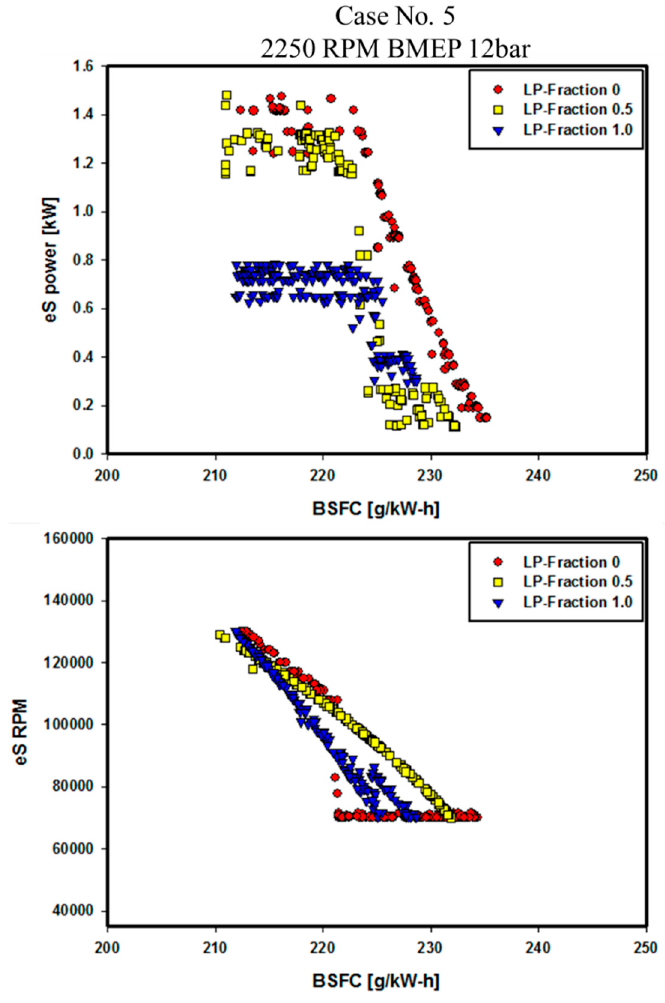
Figure 19. eS power and rpm differences for various LP fractions on the Pareto front line of case 5.